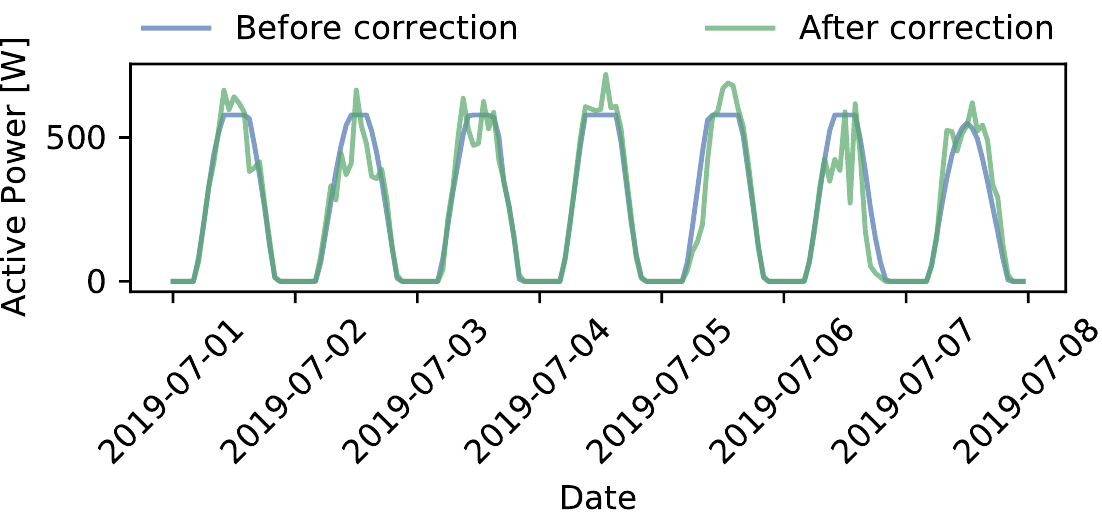
Figure 11. Curtailment profiles, before and after correction, for curtailment option